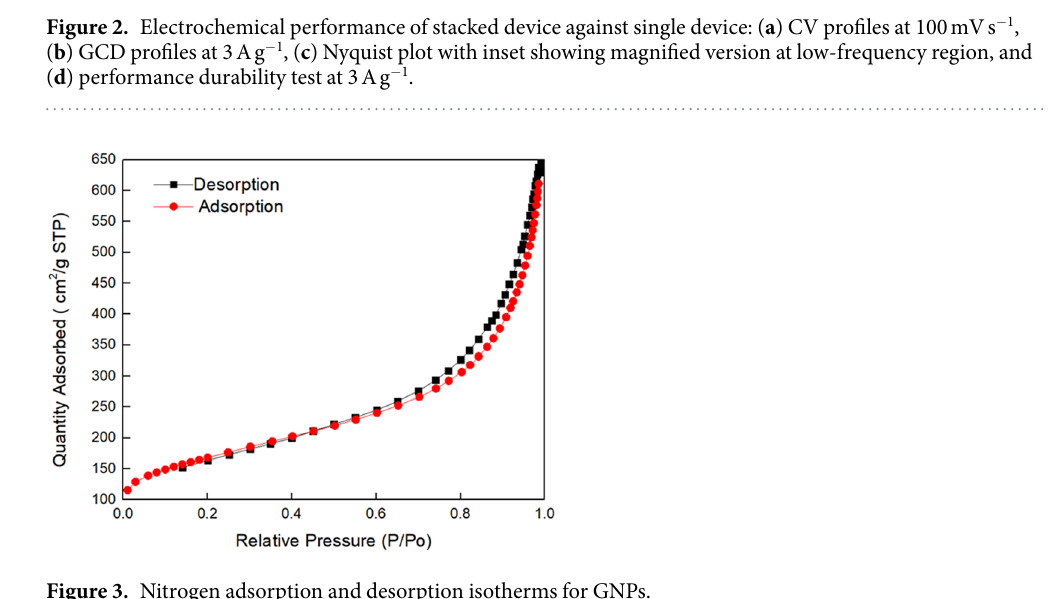
Figure 3. Nitrogen adsorption and desorption isotherms for